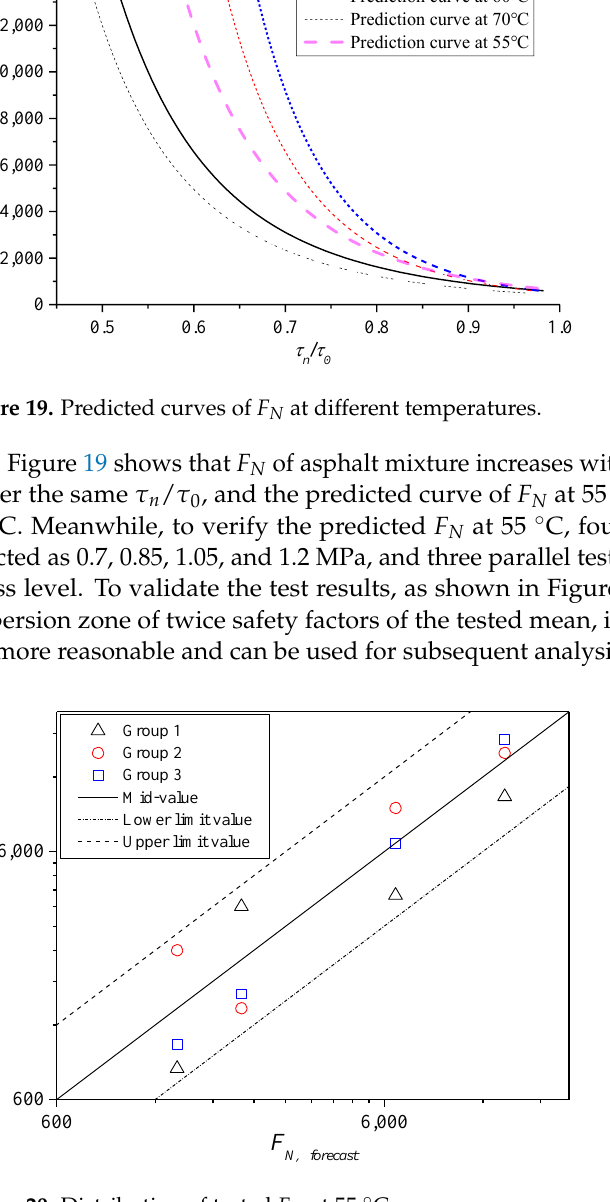
Figure 20. Distribution of tested F N at 55 °C.